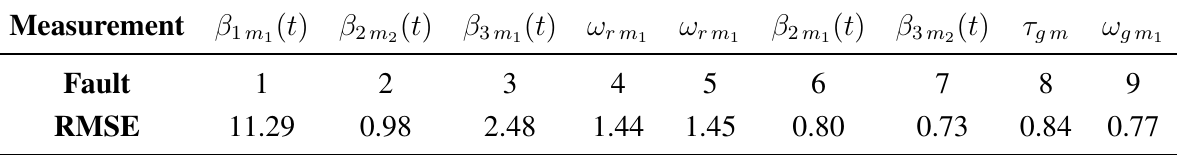
Table 2. Wind turbine failure mode and effect analysis (FMEA)